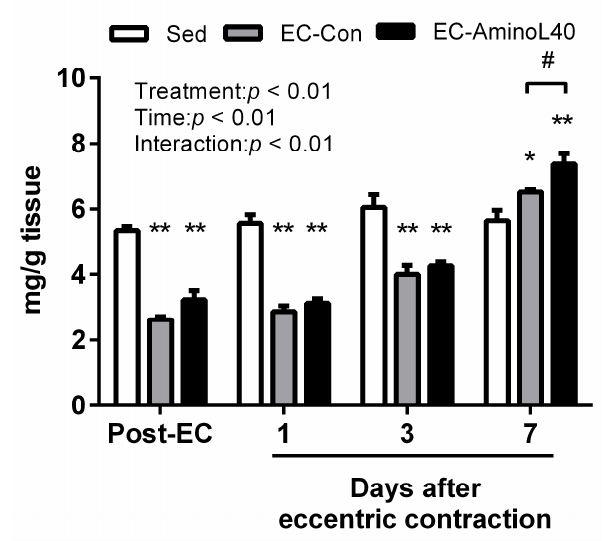
Figure 1. Muscle glycogen content in the tibialis anterior (TA) muscle immediately after eccentric contraction (Post-EC), 1, 3, and 7 days later. Muscle glycogen content was measured in the sedentary group (Sed), and in rats who underwent eccentric contractions and were given water (EC-Con) or a leucine-enriched essential amino acids mixture (EC-AminoL40). Data represent the mean ± SEM ( n = 4 (Sed) or 5 (EC groups)); * p < 0.05 vs. Sed group, ** p < 0.01 vs. Sed group, # p < 0.05 vs. EC-Con group.